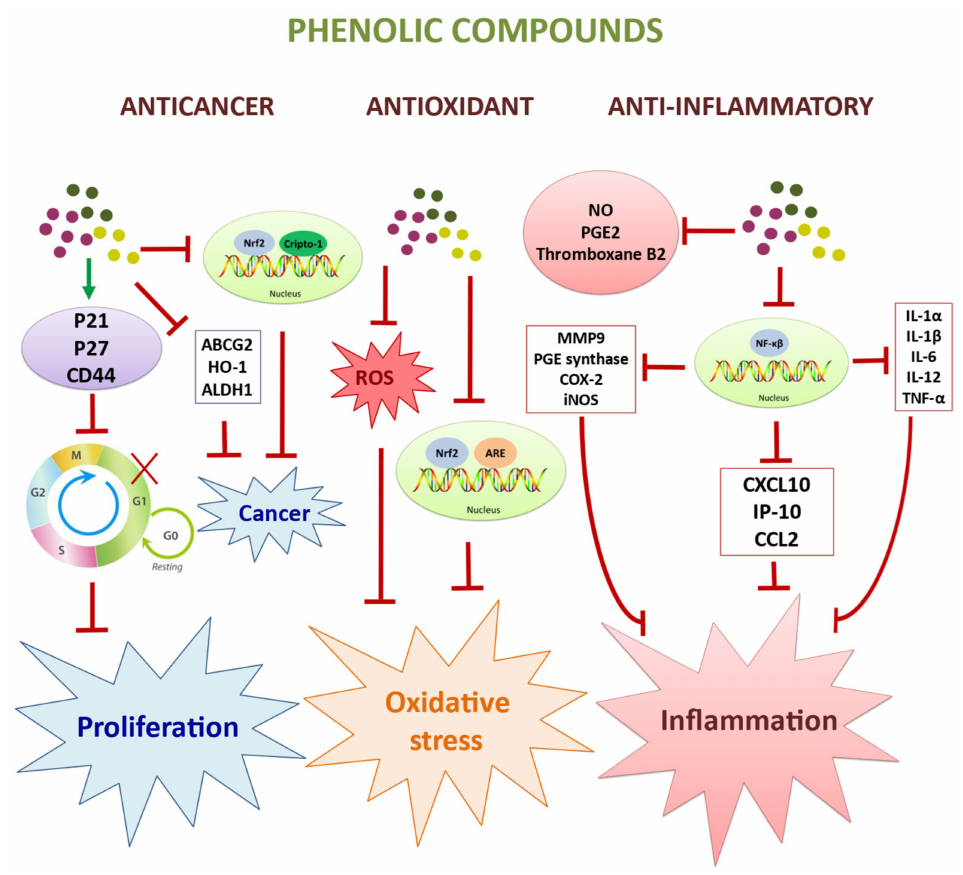
Figure 3. Schematic representation of the main molecular mechanisms involved in the action of the most important bioactivities related to the role of the polyphenols present in the fruit and leaf of the olive